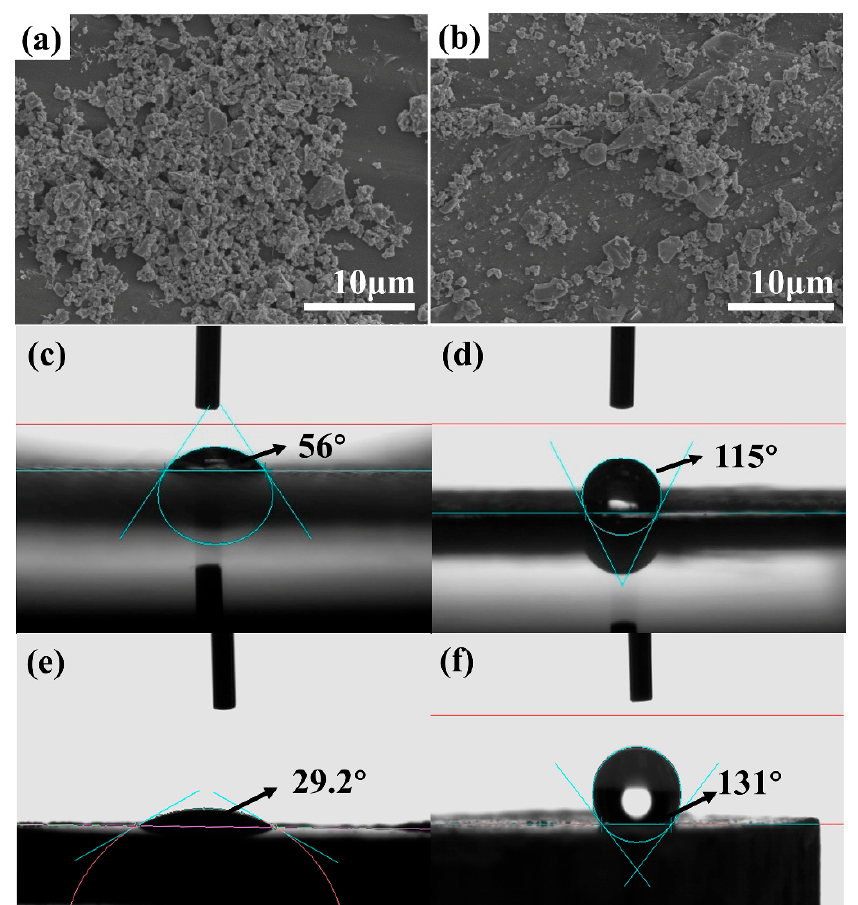
Figure 4. SEM images of ( a ) unmodified LT powders and ( b ) LT-KH570; ( c , d ) contact angle of E-glass before and after modification; ( e , f ) contact angle of LT powders before and after modification.